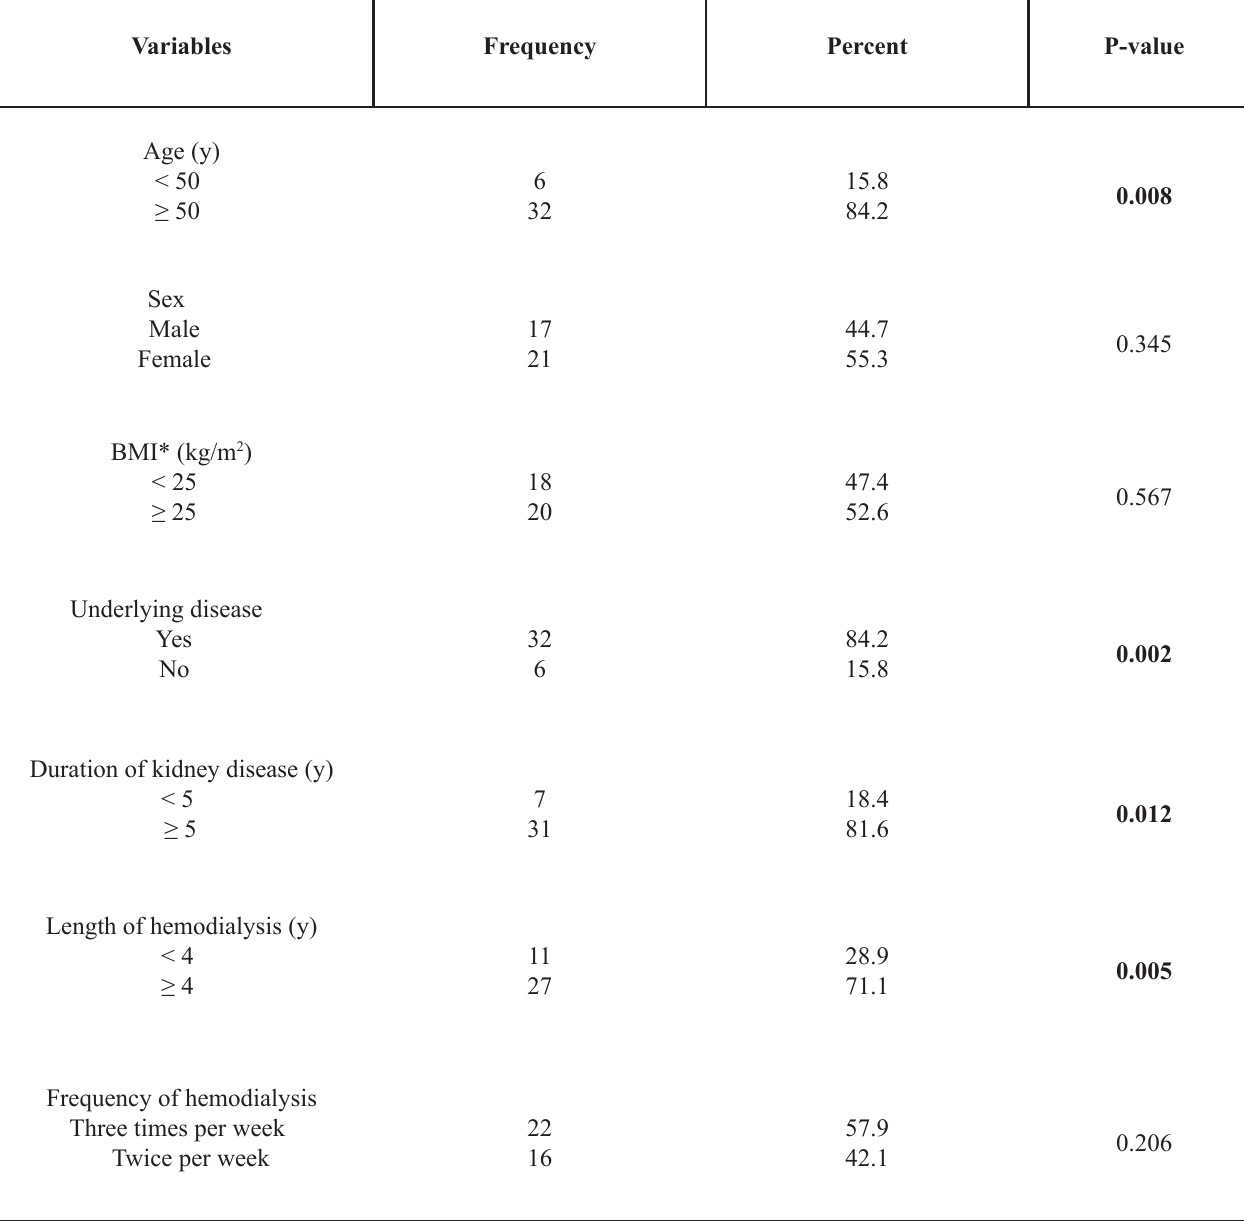
Table 1 . Demographic and clinical characteristics of ROD among patients with ERDS in subgroups